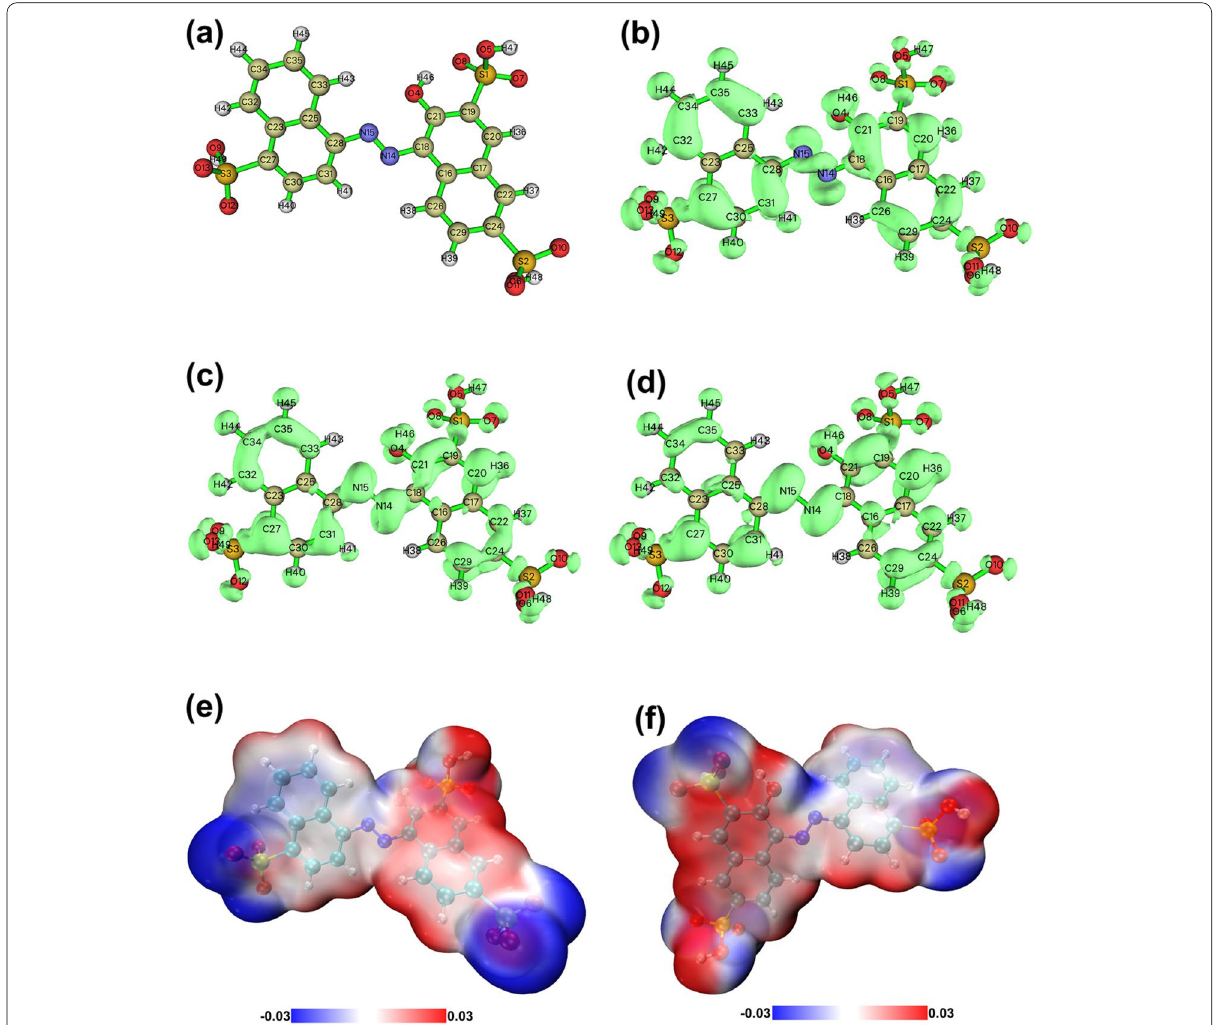
Fig. 7 Mapped isosurface of Fukui function of ARS: ( a ) labels of atoms, ( b ) f − , ( c ) f 0 , and ( d ) f + , ( e ) the front‑view, and ( f ) back‑view ESP‑mapped surface of